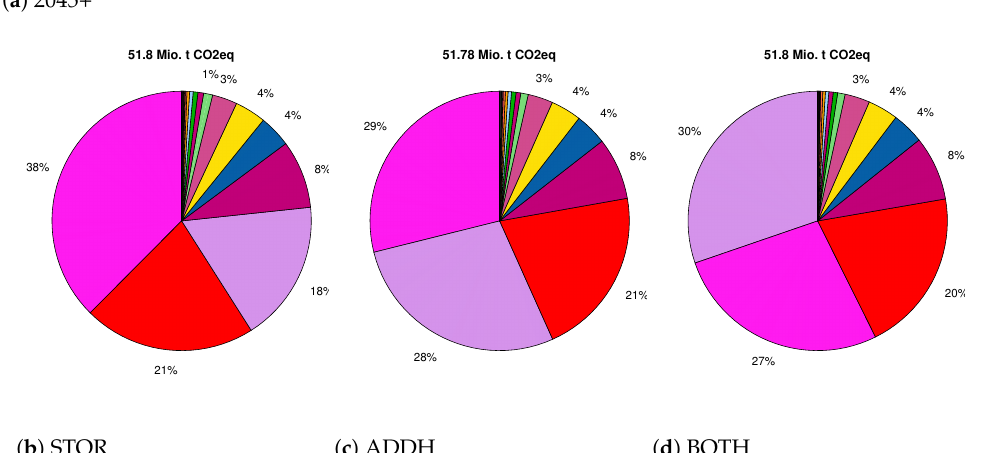
Figure A1. Distribution of emissions (direct and indirect) in t CO2eq per